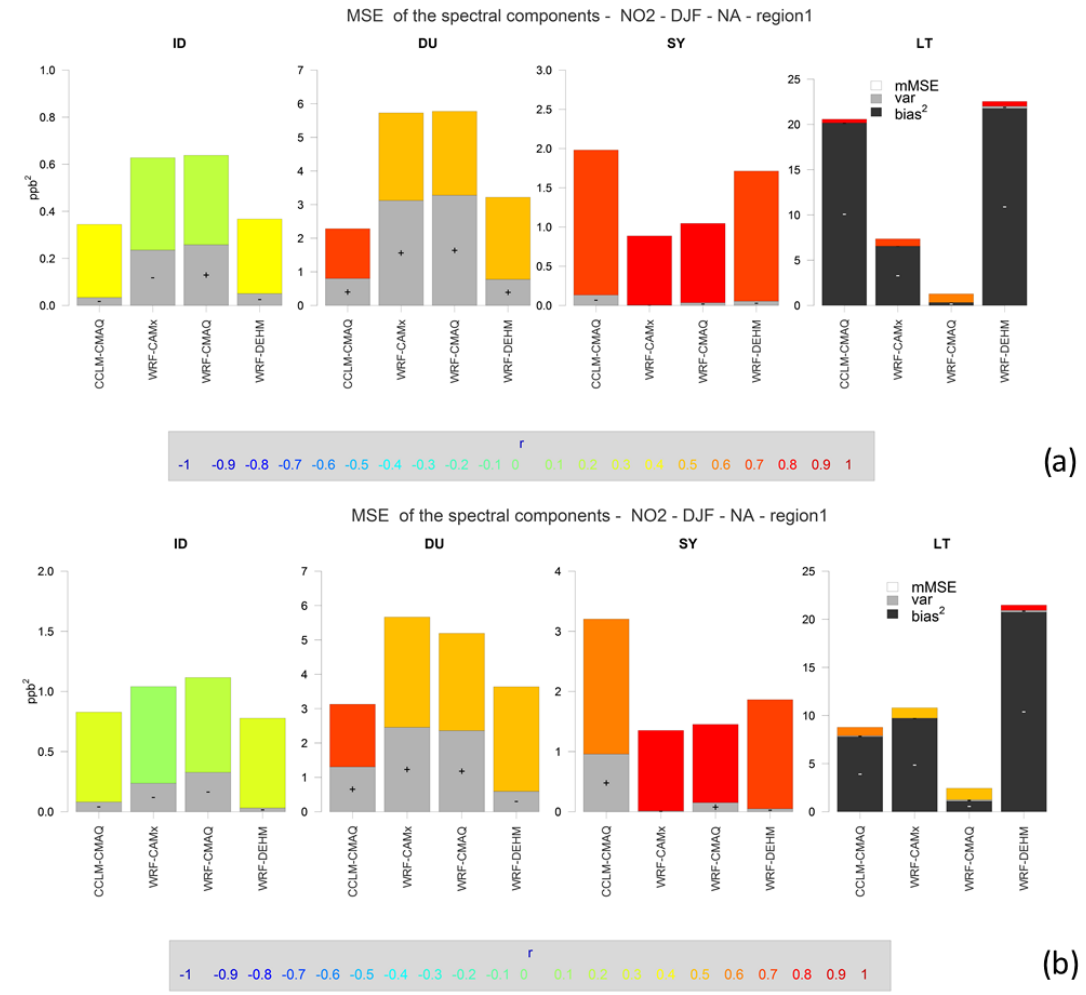
Figure 16. As in Fig. 10 but for NO 2 in NA1. Upper panel is urban sites only (39 stations); lower panel is rural sites only (10 stations).